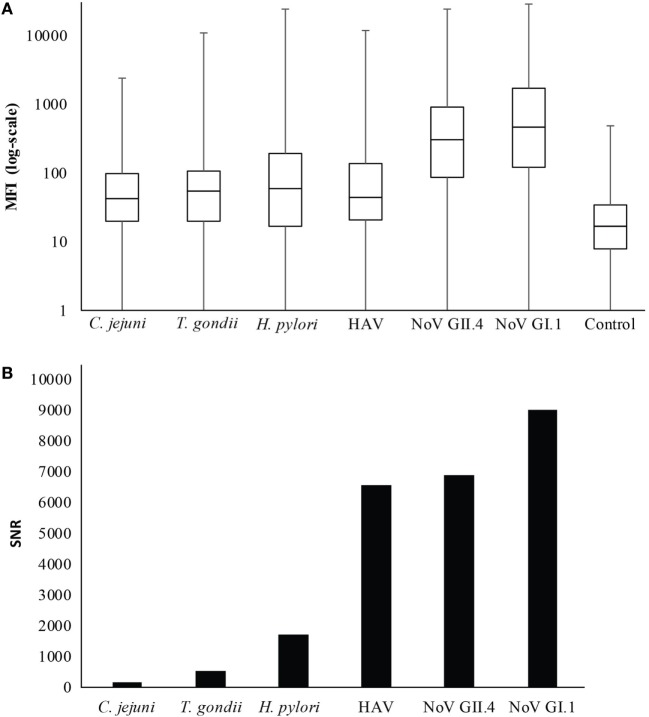
Distribution of median fluorescence intensity (MFI) results. (A) Boxplot of MFI results in log scale. The whiskers represent the minimum and maximum values. (B) Maximum signal-to-noise ratio (SNR) for each antigen in the multiplex immunoassay.